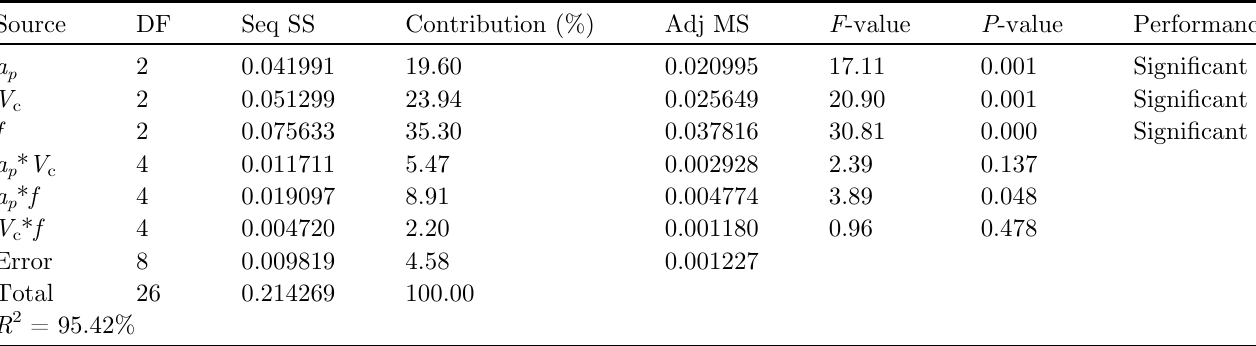
Table 5. Analysis of variance results for fl ank wear